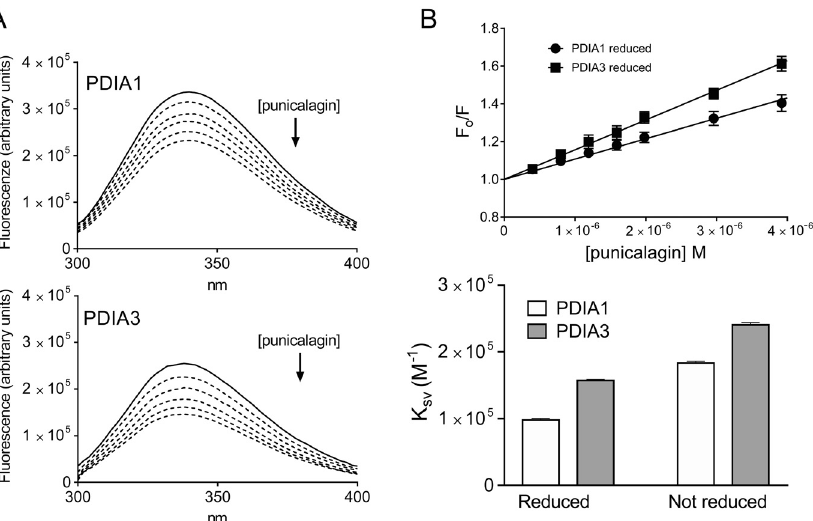
Figure 2. Protein fluorescence quenching analysis of PDIA1 and PDIA3 in the presence of punicalagin: ( a ) Fluorescence quenching spectra of reduced PDIA1 and PDIA3 alone (solid line) and after stepwise addition of punicalagin (dotted line) (pH 7.4, 25 ◦ C, and λ ex = 290 nm, (PDI) = 0.1 × 10 − 6 M, (punicalagin) = 4 × 10 − 6 M final concentration); ( b ) Stern–Volmer plot of quenching data of reduced PDIs in the presence of increasing concentrations of punicalagin. Stern–Volmer constants (K SV ) calculated for the different systems tested. Data represent the mean of at least three independent experiments, and error bars indicate SEM. Table 1. Stern–Volmer constants (K SV ) and dissociation constant (K d ) obtained by fluorescence quenching analysis of PDIA1 and PDIA3 in the presence of punicalagin. Data were calculated from fluorescence quenching analysis using both proteins (0.1 × 10 − 6 M) in reducing and non-reducing conditions (pH 7.4, 25 ◦ C) and increasing concentration of punicalagin (up to 4 × 10 − 6 M). K SV are reported as mean and SEM of at least three independent